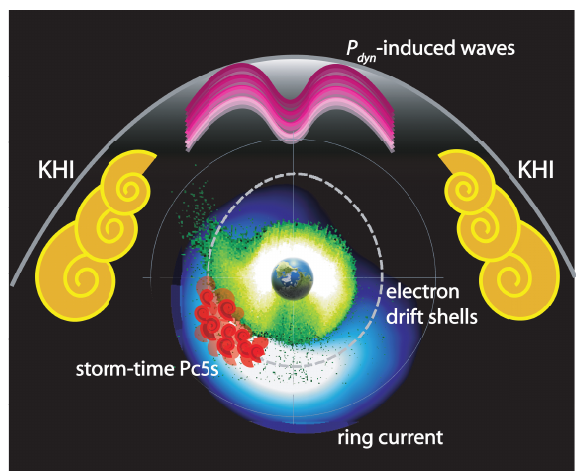
Fig. 1. Pc5 pulsations in the inner magnetosphere can be classified by their energy sources. The external pulsations are driven by solar wind variations at the day side magnetopause, while the internal pulsations are the result of low frequency instabilities of ring current